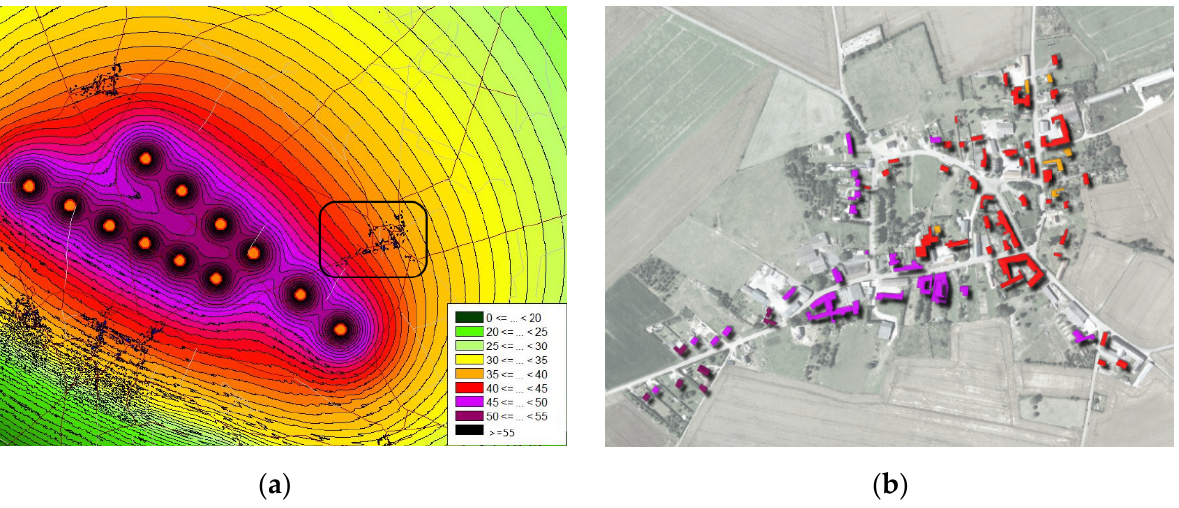
Figure 3. Example of the result of the calculation of the radiated sound from a wind farm ( a ), and of the exposure of the buildings in the nearby village enclosed by the black block in ( a , b ).